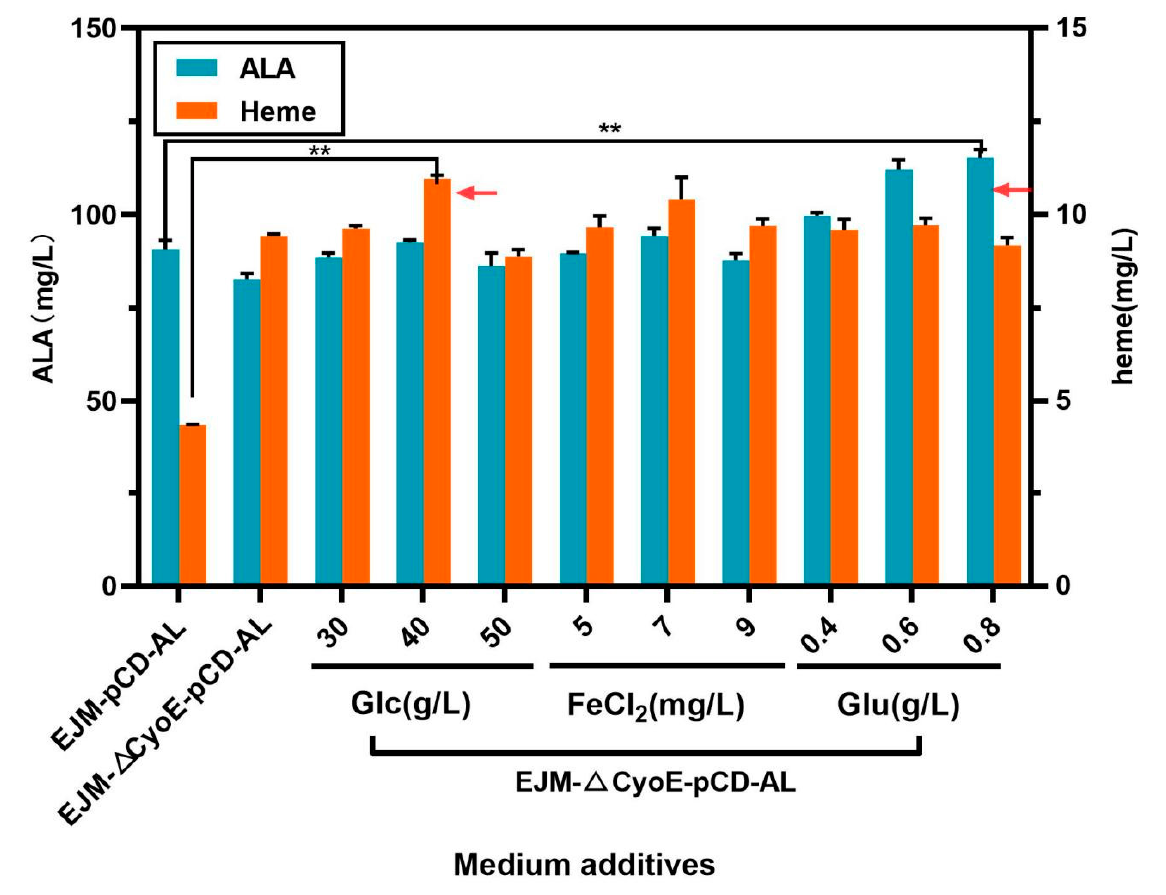
Figure 5. Heme and ALA production of recombinant strain EJM- ∆ CyoE-pCD-AL under medium- optimized conditions. The abscissa shows the heme and ALA production of control strain EJM- pCD-AL and the yield of recombinant strain EJM- ∆ CyoE-pCD-AL under optimized conditions, respectively. The symbol ** stands for and p < 0.01, as determined by Student’s t-test.